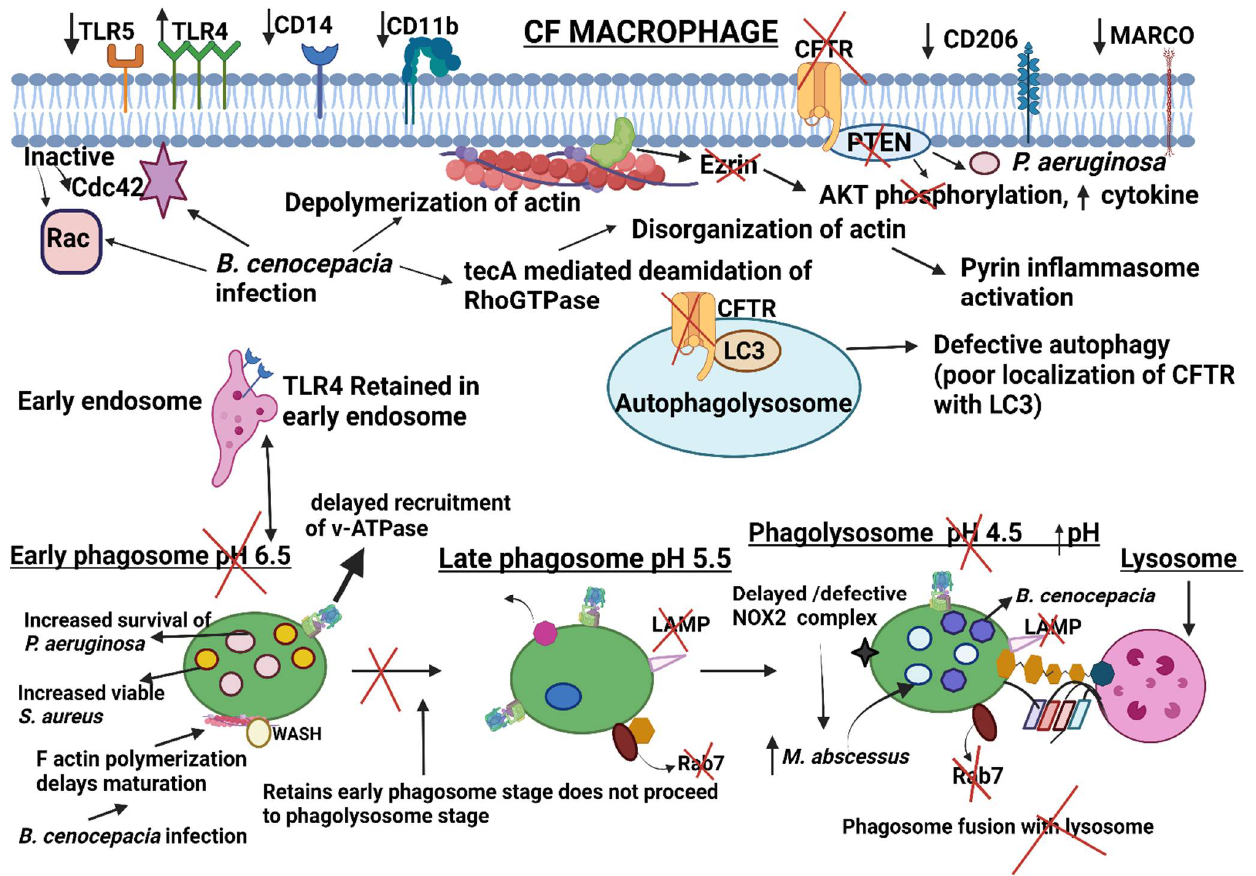
Figure 3. Schematic representation of phagocytosis defects in CF macrophages. Dysregulation of surface receptors, actin cytoskeleton dynamics, phagosome maturation, and autophagosome formation are shown during infection in CF macrophages. (1) Decreased expression of receptors such as TLR5, CD14, CD11b, CD206, and MARCO are displayed in CF macrophages. (2) Dysregulation of the actin cytoskeleton due to inactive Cdc42, Rac, and tecA mediated disorganization of actin during B. cenocepacia infection is shown. Ezrin links the actin cytoskeleton to the plasma membrane. (3) Poor ezrin expression in CF macrophages leads to decreased AKT phosphorylation and increased cytokine expression. Increased TLR4 expression and retained TLR4 in early endosomes is demonstrated. (4) Dysregulation of phagosome maturation is shown in CF macrophages. Delayed recruitment of V-ATPase, increased acidification of phagosomes, and F actin polymerization of phagosomes prevents maturation of phagosomes. During B. cenocepacia infection, the phagosome proceeds to the early phagosome stage but does not mature to the phagolysosome stage and bacteria survive inside the phagolysosome and prevent phago-lysosomal fusion. (5) Defective colocalization of CFTR with LC3 is observed in autophagosomes leading to defective autophagy. Increased survival of P. aeruginosa , S. aureus , and B. cenocepacia in CF macrophage result from defective autophagy. (6) Absence of the CFTR-PTEN complex decreases Akt phosphorylation and thereby increases pro-inflammatory cytokines. Also, insufficient amounts of active PTEN contribute to defective clearance of intracellular P. aeruginosa